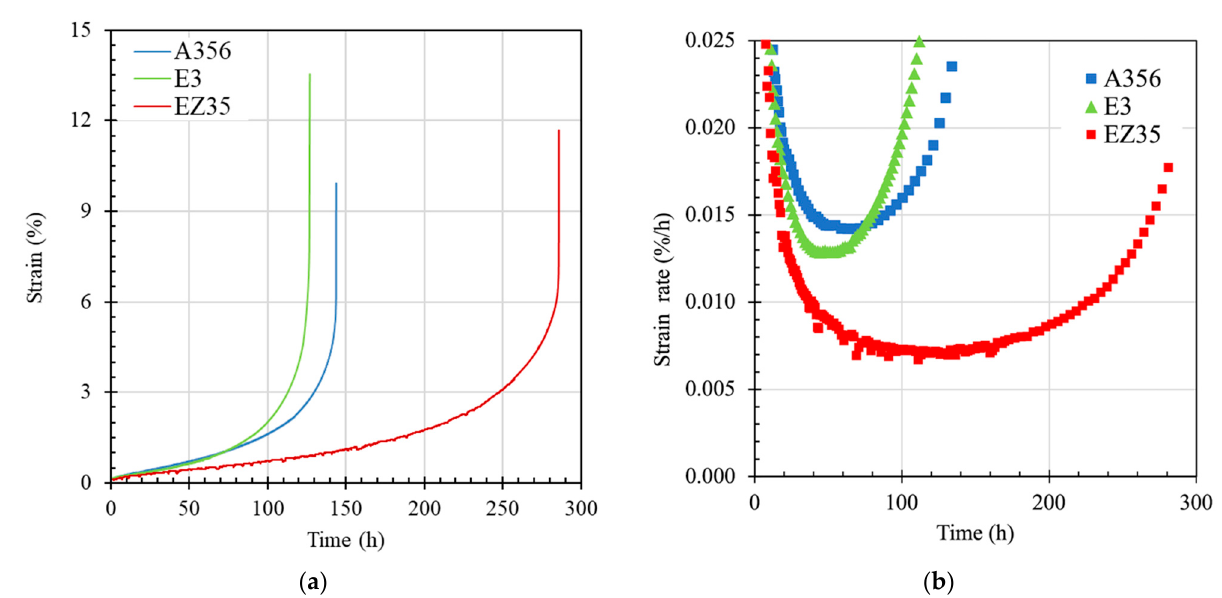
Figure 1. Results of creep tests carried out on the reference and modified alloys at 300 °C, 30 MPa. ( a ) Strain vs. time curves and ( b ) creep strain rate vs. time.